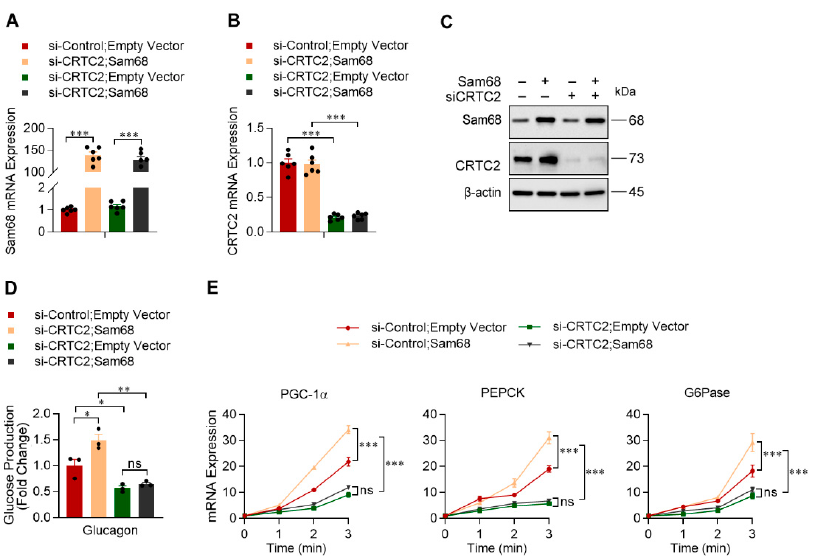
Figure 4. Sam68 promotes gluconeogenesis through CRTC2. pcDNA3-HA-Sam68 or pcDNA3-HA (Empty) plasmid was co-transfected with CRTC2 siRNA or non-targeting siRNA in HepG2 cells; 48 h later, the efficiencies of transfections were evaluated by qRT-PCR for Sam68 ( A ) and CRTC2 ( B ) mRNA expression and by Western blotting for ( C ) Sam68 and CRTC2 protein levels. n = 3. The transduced cells were also treated with glucagon (100 nM), then ( D ) glucose produced in the cell- culture media was measured after 4 h of treatment ( n = 3), and ( E ) mRNA expression of PGC-1 α , PEPCK, and G6Pase were evaluated at 0 [basal], 1, 2, and 3 h of treatment ( n = 3 per time point). Data are expressed as mean ± s.e.m. * p < 0.05, ** p < 0.01, *** p < 0.001, ns, not significant (two-way ANOVA). 2.4. Glucagon Promotes Sam68 Nuclear Import, Whereas Insulin Elicits Its Nuclear Export Consistent with the observation that insulin induces Sam68 cytoplasmic transloca- tion in rat adipocytes [30,31], we found in mouse primary hepatocytes that, after insulin treatment, Sam68 abundance was increased in the cytoplasm but decreased in the nucleus, while total Sam68 protein amount was unchanged (Figure 5A). Interestingly, contrasting effects (i.e., Sam68 abundance was increased in the nucleus but decreased in the cyto- plasm) were observed when the cells were treated with glucagon (Figure 5B). Further- more, we analyzed Sam68 protein levels in the cytoplasmic and nuclear fractions of liver tissues from mice that had received intraperitoneal injection of insulin or glucagon. Our results confirmed that insulin induces Sam68 translocation from the nucleus to cytoplasm (Figure 5C) and glucagon elicits Sam68 translocation in the opposite direction (Figure 5D) in vivo in the physiological state.